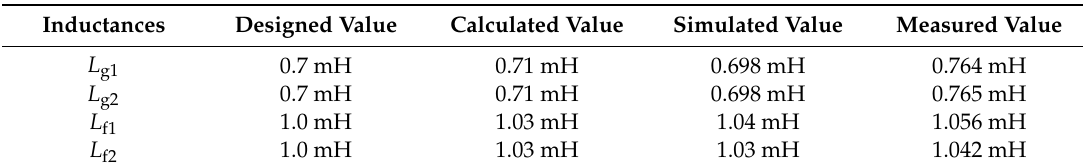
Table 4. Inductances obtained by different methods.